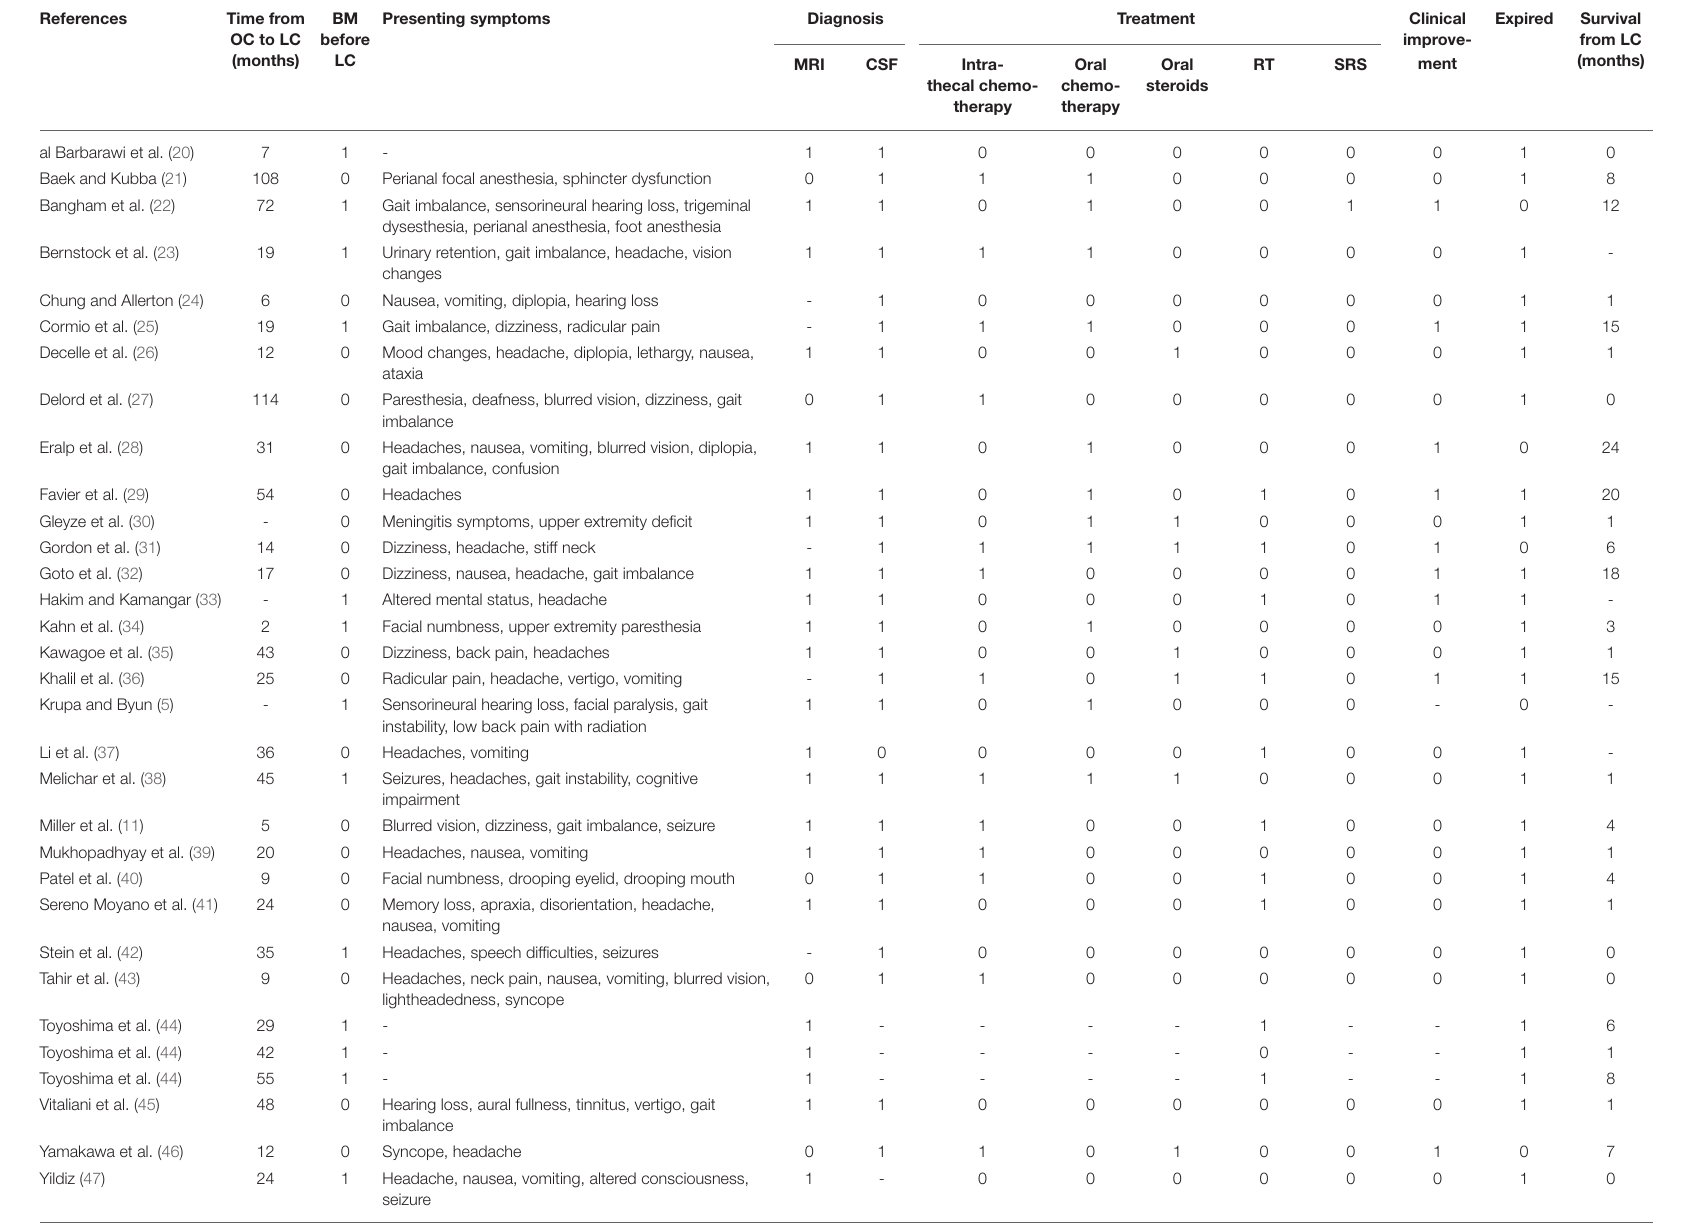
BM, brain or spine metastasis; LC, leptomeningeal carcinomatosis; OC, ovarian cancer; RT, radiation therapy; SRS, stereotactic radiosurgery; 0, no; 1